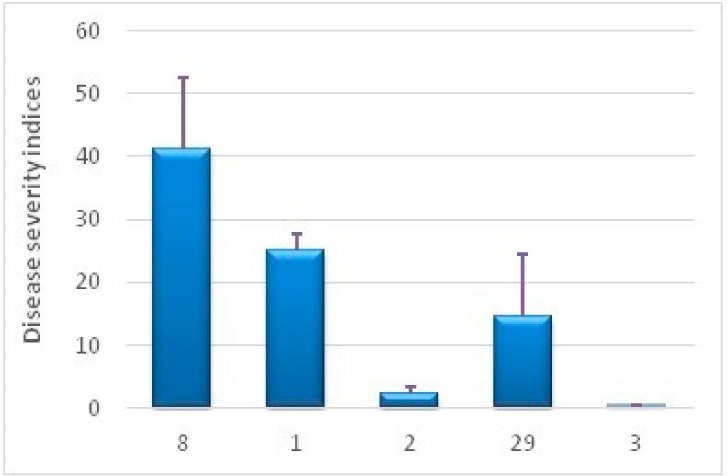
Figure 1. Susceptibility of potato varieties to early blight measured in disease indices. The varieties used were: 8, Udacha; 1, Zhukovsky ranny; 2, Yubiley Zhukova; 29, Skoroplodny; 3,